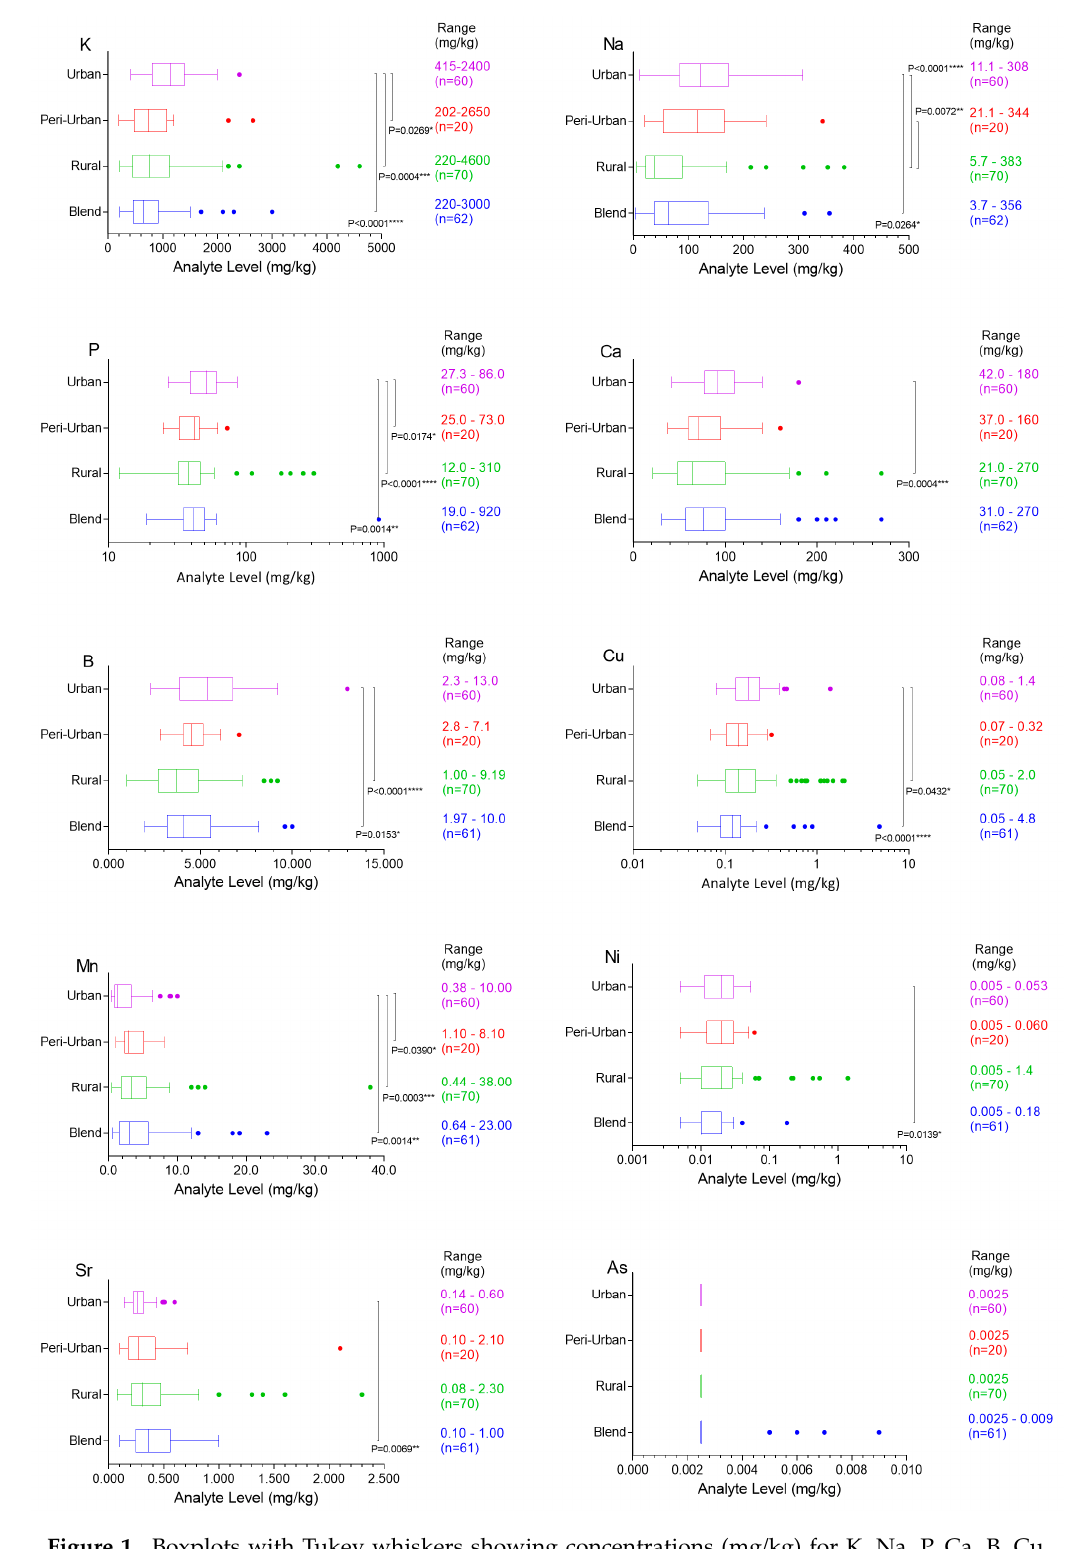
Figure 1. Boxplots with Tukey whiskers showing concentrations (mg/kg) for K, Na, P, Ca, B, Cu, Mn, Ni, Sr and As for honey samples categorized as urban, peri-urban, rural or blend. Significant differences were determined using one-way non-parametric Kruskal–Wallis ANOVA with Dunn’s multiple comparisons test, giving adjusted P values, **** p < 0.0001, *** p = 0.0001–0.001, ** p = 0.001–0.01, * p = 0.01–0.05, ns p ≥ 0.05.